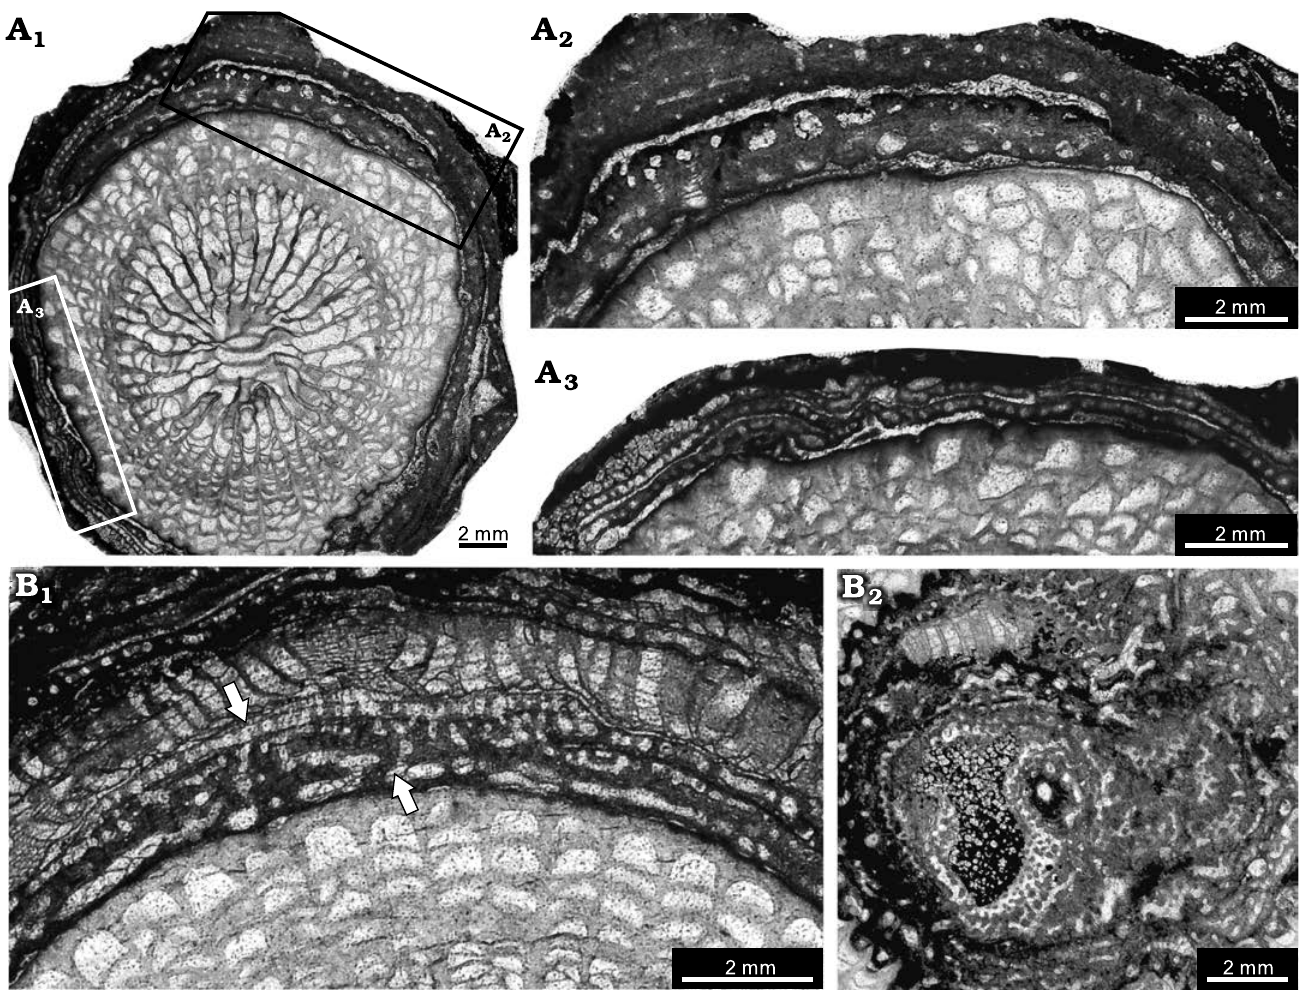
Fig. 6. Stromatoporoid Clathrocoilona spissa (Lecompte, 1951), from the Jiwozhai reef, Jiwozhai Member, Dushan Formation, Givetian, Middle Devonian; Dushan, Guizhou, South China. A . NIGP 177048; A 1 , longitudinal section showing the contemporarily encrusting layers, with black and white rectangles illustrating details; A 2 , A 3 , enlargement of A 1 , note the obvious discrepancy between different areas in the same stromatoporoid: the condensed skeletons of A 2 are similar to Clathrocoilona spissa (Lecompte, 1951) and thin laminae of A 3 are consistent with Clathrocoilona obliterata (Lecompte, 1951). B . NIGP 177049; B 1 , longitudinal section, note the intra-specific variations (white arrows) of the lower irregular layers similar to Clathrocoilona crassitexta (Lecompte, 1951) and the upper regular layers identical to Clathrocoilona obliterata (Lecompte, 1951); B 2 , tangential